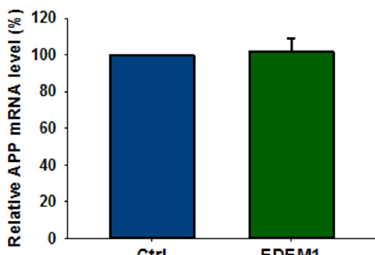
Figure 4. High expression of EDEM1 does not affect APP transcription in HEK293 cells. Relative APP mRNA level in HEK293 cells expressing EDEM1 was quantitatively assessed by real-time RT-PCR. Measurements were performed with the use of the Roche Universal Probe Library (UPL) assays. Expression of GAPDH mRNAs was used as reference control. Values obtained for cells without EDEM1 overexpression are indicated as 100%. Values representing EDEM1-transfected cells are plotted relative to 100%. The values are expressed as mean ± SD, n = 3, Student’s t test.